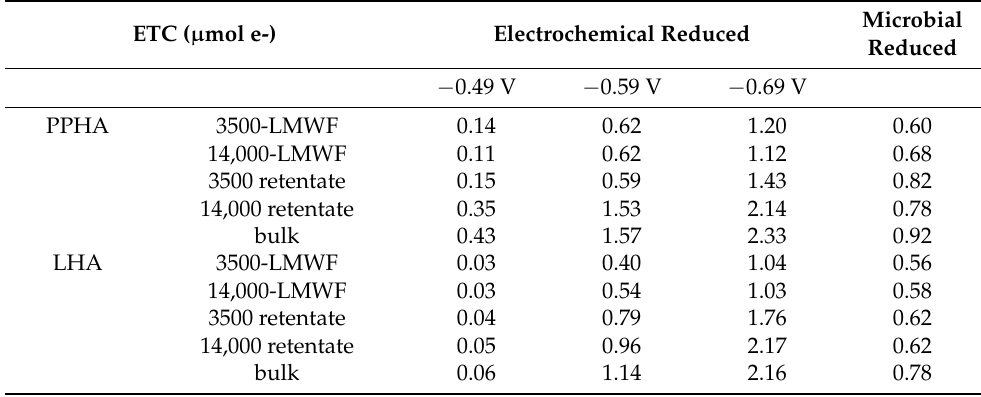
Table 2. Comparison in ETC between electrochemical reduction and microbial reduction of HA with different molecular weight